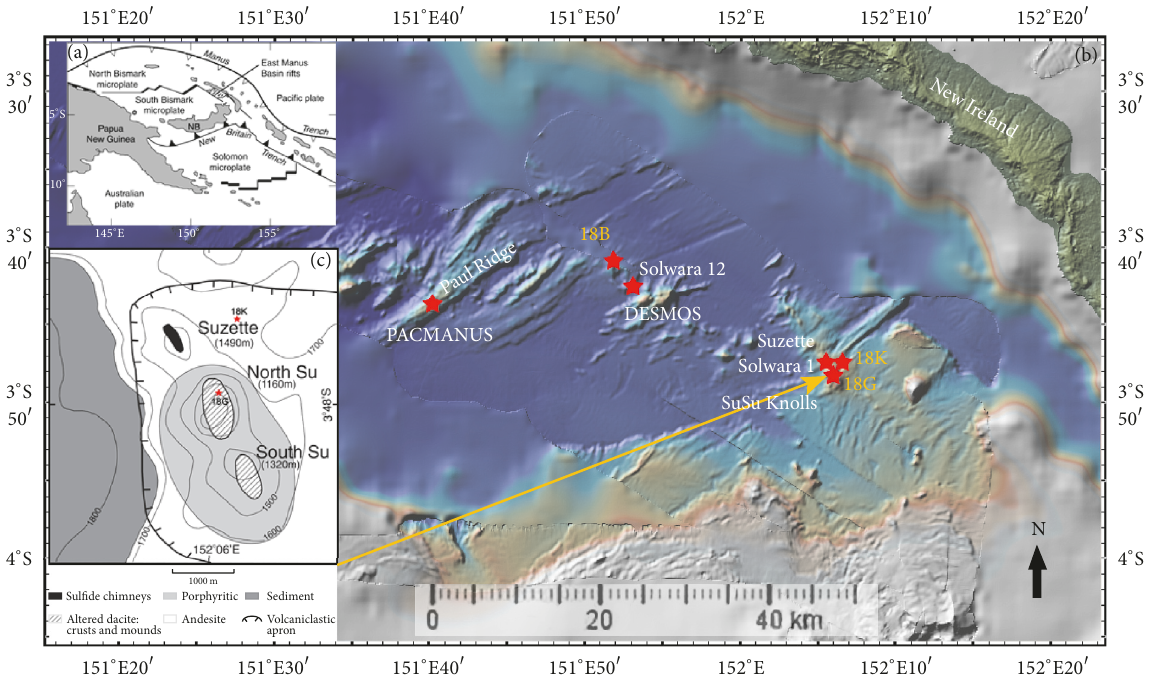
Figure 1: Distribution of CTD hydrocast stations. (a) Geological map showing the tectonic setting (from [20]). (b) The bathymetric chart of the survey area in the eastern Manus basin (bathymetric map and data from http://www.geomapapp.org/index.htm). (c) Map of the SuSu Knolls hydrothermal field showing the active Suzette, North Su, and South Su vent site (redrawn and modified from [21]). Station 18B is located about 1.8km north-northwest of the DESMOS caldera rim; Station 18K is 1.3 km to the east of Solwara 1, which is the name now used for the chimney field on the Suzette volcanic edifice, where the host rock is andesite; Station 18G lies between the crests of North Su and South Su where porphyritic dacite and altered dacite overlie older andesitic lavas. NB: New